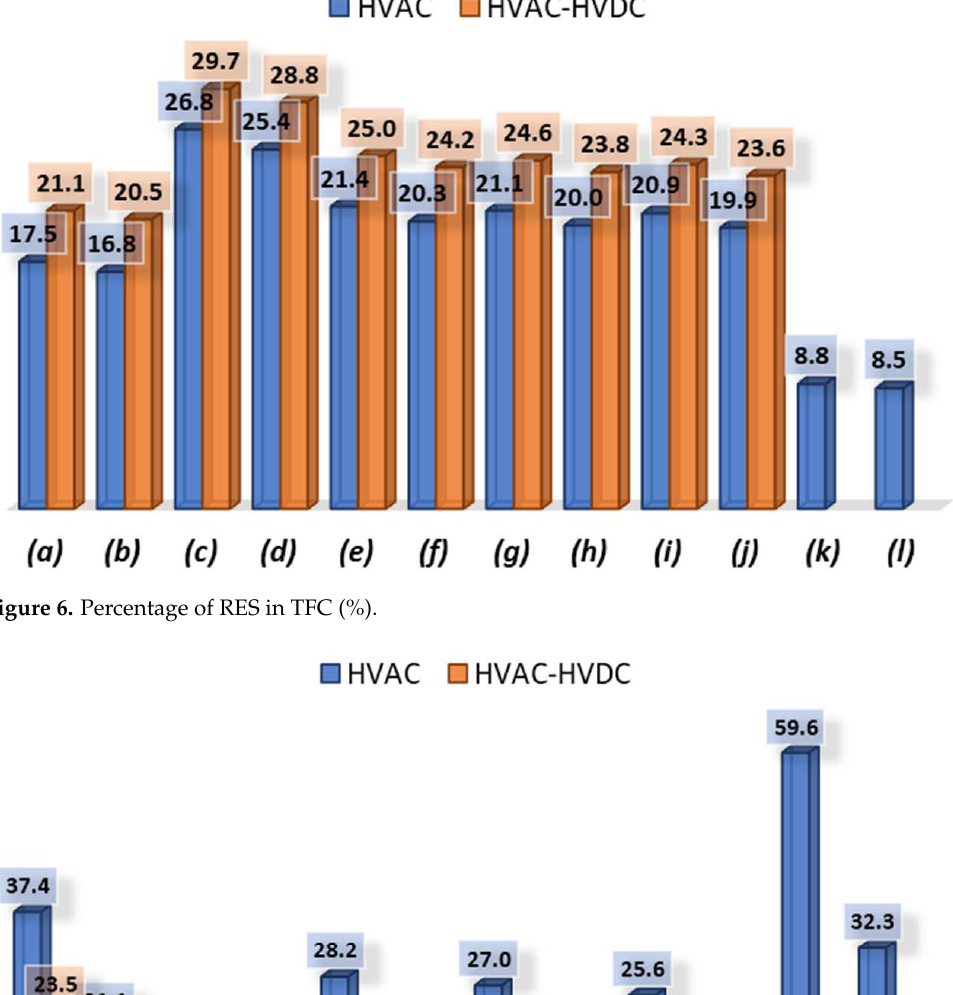
Figure 5. Reserve margin (GW).